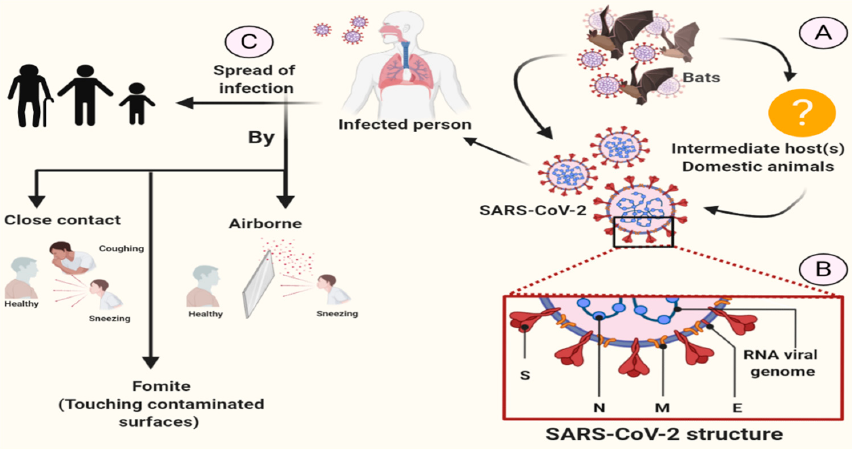
Figure 1. The coronavirus disease (COVID ‐ 19) transmission.